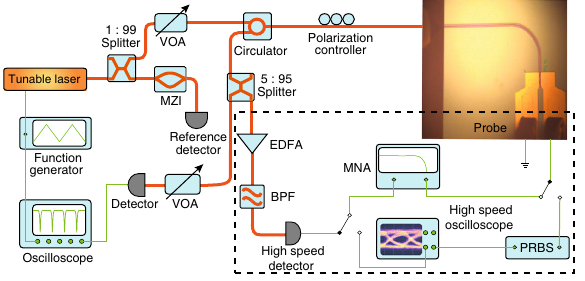
Fig. 3 Experimental testing setup. Light is coupled into and out of the EOM chip via one lensed fi ber. The inset shows an optical microscopic image of an EOM with the RF probe in contact. The equipment in the highlighted dashed box is used for characterizing the performance of electro-optic modulation. VOA variable optical attenuator, MZI Mach – Zehnder interferometer, EDFA erbium-doped fi ber ampli fi er, BPF bandpass fi lter, MNA, microwave network analyzer, PRBS pseudo-random binary sequence source.